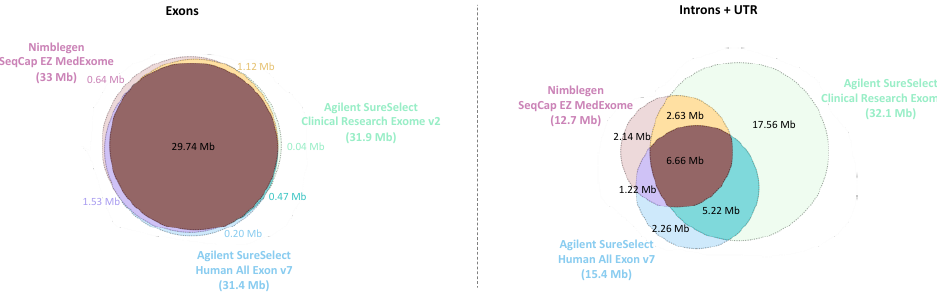
Figure 2. Venn diagram showing the overlap of targeted bases of the different ES designs for non- coding (UTR + intron) regions and coding regions. The MedExome (Medex) has a target size of 47 Mb covering 33 Mb of exonic regions, 10.8 Mb of intronic regions, and 1.9 Mb of UTR. The SureSelect Human All Exon V7 exome (SSV7) presents a target size of 48 Mb composed of 31.9 Mb of exonic regions, 13.4 Mb of intronic regions, and 2 Mb of UTR. The Clinical Research Exome V2 (CREV2) has the largest target size with 67.3 Mb due to its larger intronic regions coverage (25.7 Mb) and UTR (6.4 Mb), whereas the exonic regions size is similar to the two other designs (31.4 Mb). The associated Venn diagrams were generated with Plotly (Plotly Technologies Inc. Collaborative data science. Montréal, QC, Canada, 2015.https://plot.ly accessed on 10 March 2019).